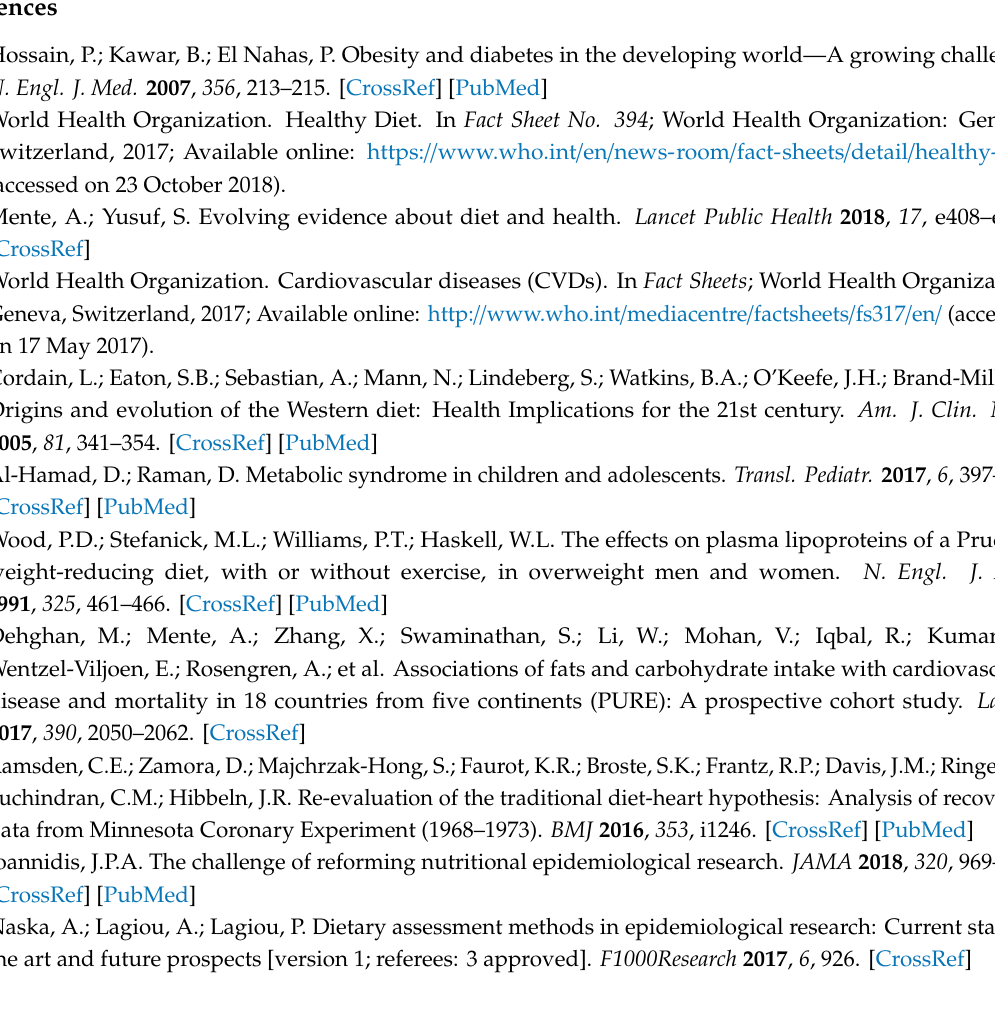
Figure S10: ROC curves for top-ranked single and ratiometric plasma and urinary biomarkers of contrasting Prudent and Western diets; Figure S11: Trajectory plots for plasma metabolites as biomarkers of contrasting diets for individual DIGEST participants; Figure S12: Trajectory plots for creatinine-normalized urinary metabolites as biomarkers of contrasting diets for individual DIGEST participants; Figure S13: Linear correlation plots for plasma and creatinine-normalized concentrations of Me-His and ProBet in plasma and urine for DIGEST participants; Figure S14: 2D heat maps and correlation matrices for plasma and urinary metabolites associated with contrasting diets from food